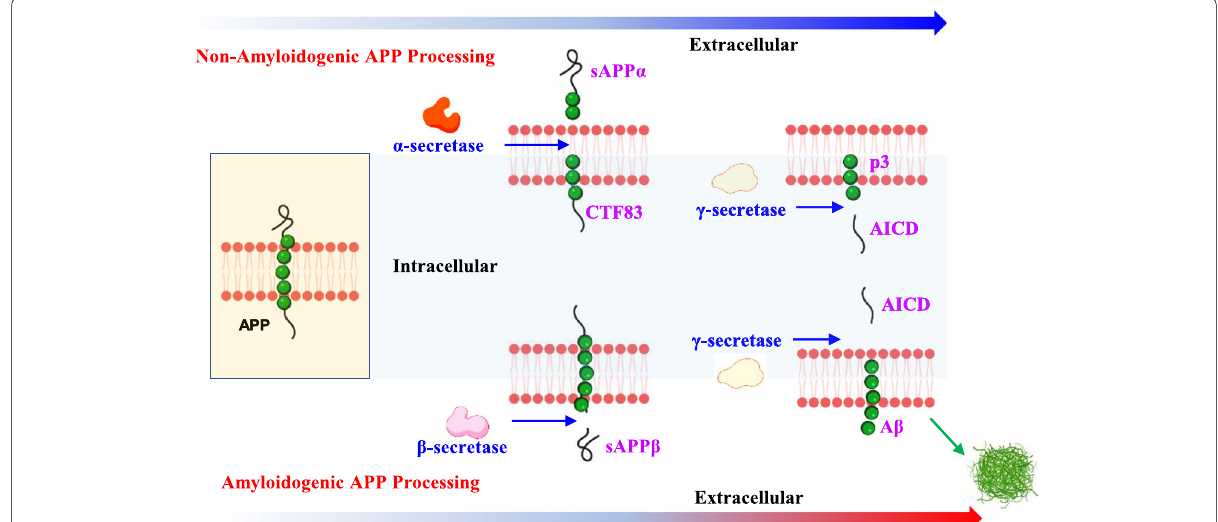
Fig. 1 Diagram of amyloid plaque formation. APP, a transmembrane protein, is cleaved by three enzymes, including α, β, and γ‑secretase. In the normal physiological state, most of the APP (90% or more) are cleaved by α‑secretase and γ‑secretase, which generates sAPPα and C terminal fragments (p3, CTF 83, and AICD50). However, under pathological conditions, most of the APP undergoes the amyloidogenic APP processing pathway, wherein Aβ generation is significantly increased and induces the formation of Aβ amyloid fibrils. APP, amyloid precursor protein; sAPPα, soluble amyloid precursor protein α; sAPPβ, soluble amyloid precursor protein β; ACID, APP intracellular domain; CTF, carboxy‑terminal